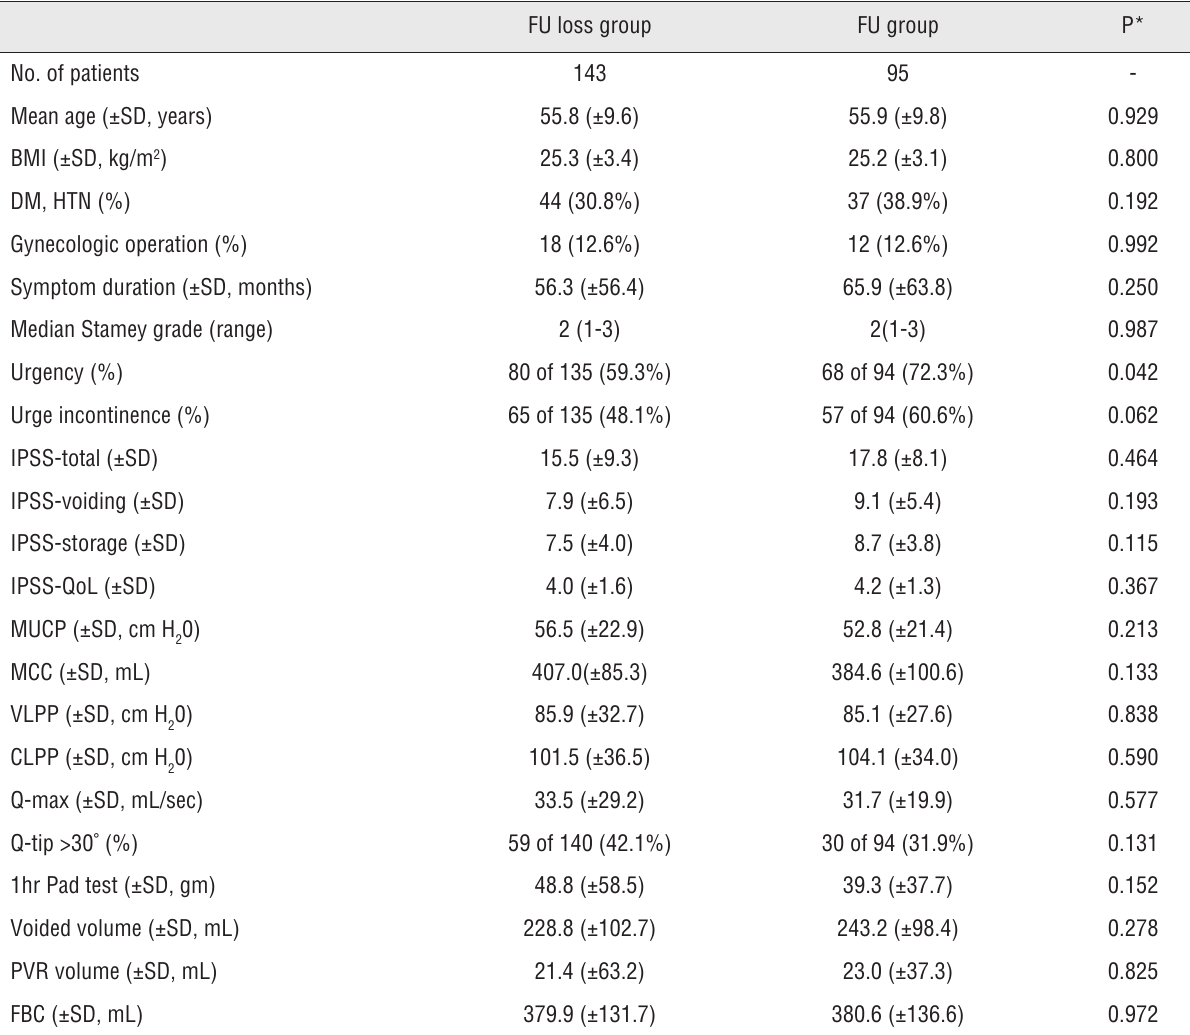
Table 2 - Baseline characteristics and preoperative findings.